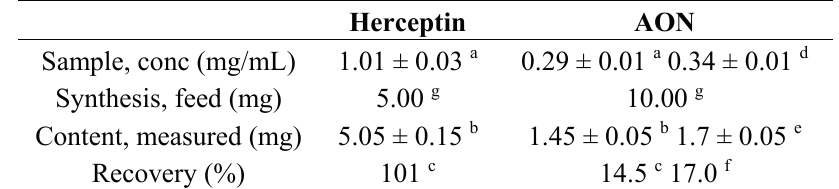
Table 1. Quantitative analysis of nanoconjugate components after ammonolysis.